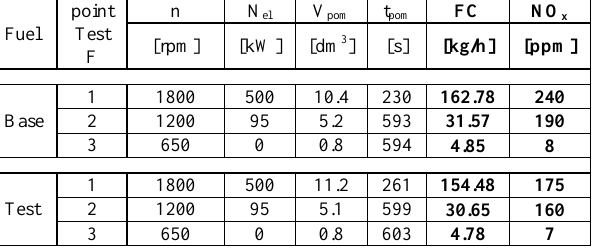
Table 3. Values of parameters set and measured in test F for the 6Dg locomotive with a C27 engine fueled with the tested fuels